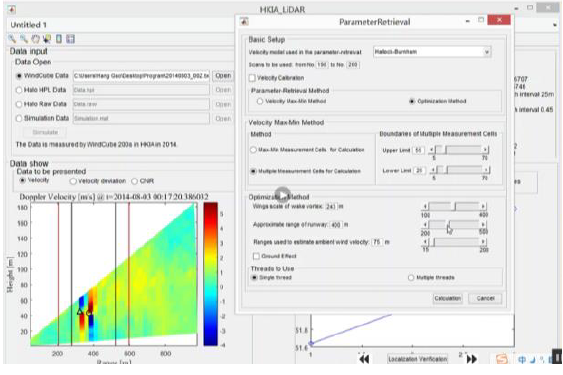
Fig. 3 Wake Vortex Parameter-Retrieval System